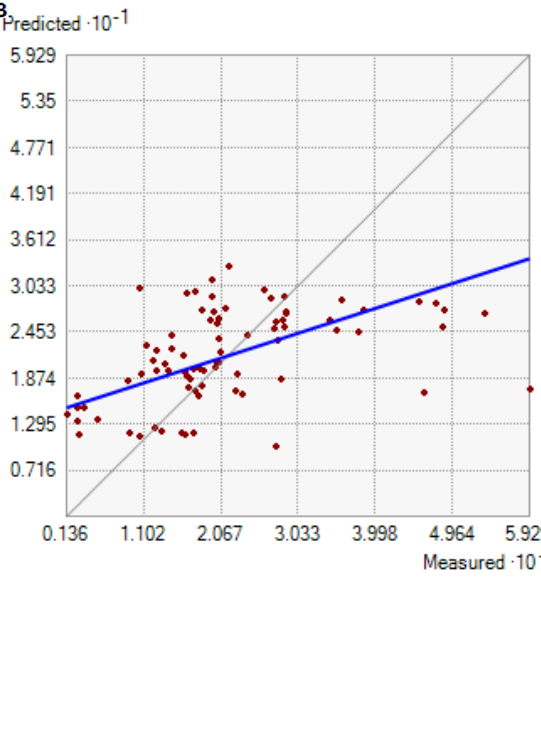
Figure A2. Plot of predicted versus measured values of (A) log-transformed K s (ms -1 ), (B) SOM, (C)